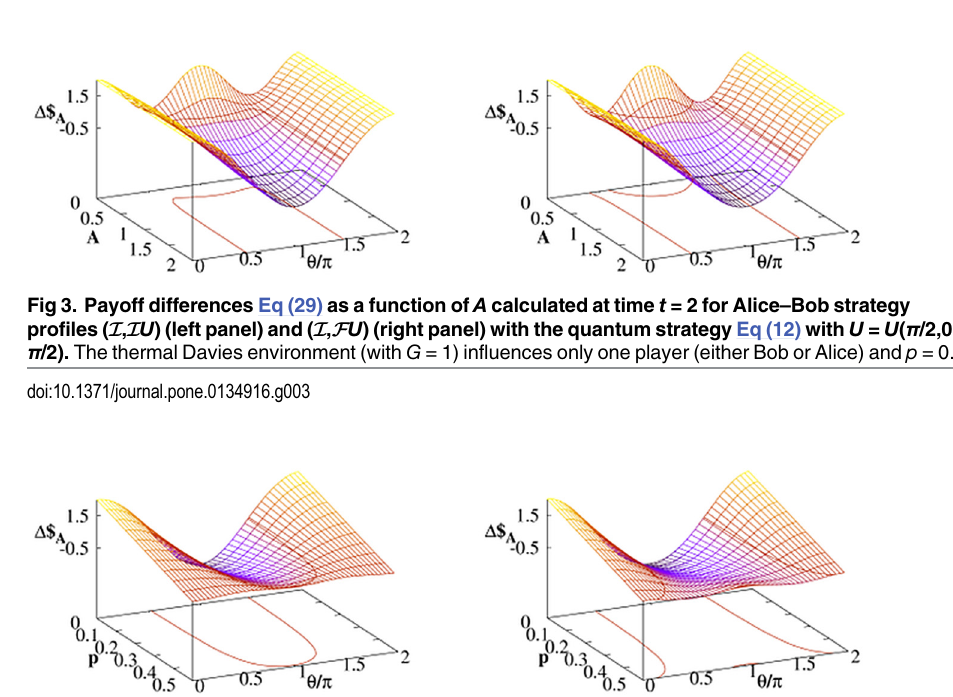
Fig 4. Payoff differences Eq (29) as a function of temperature p calculated at a time t = 2 for Alice – Bob strategy profiles ( I , I U ) (left panel) and ( I , F U ) (right panel) with the quantum strategy Eq (12) with U = U ( π /2,0, π /2). The thermal Davies environment (with G = 1) influences only one player (either Bob or Alice) and A = 2.